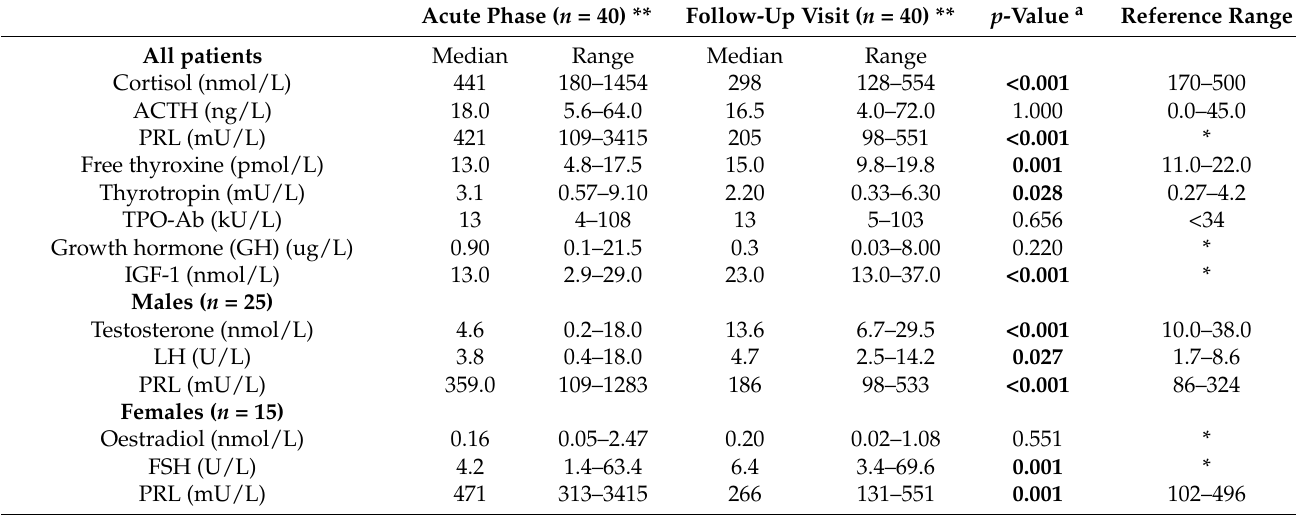
Table 2. Serum and plasma hormone levels during acute Puumala hantavirus infection and on a follow-up visit one month after discharge from hospital.